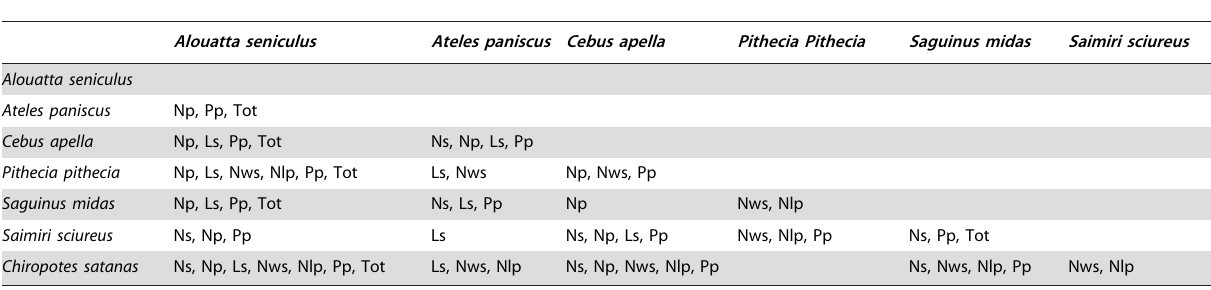
Table 3. Tukey 9 s HSD pairwise comparison test.